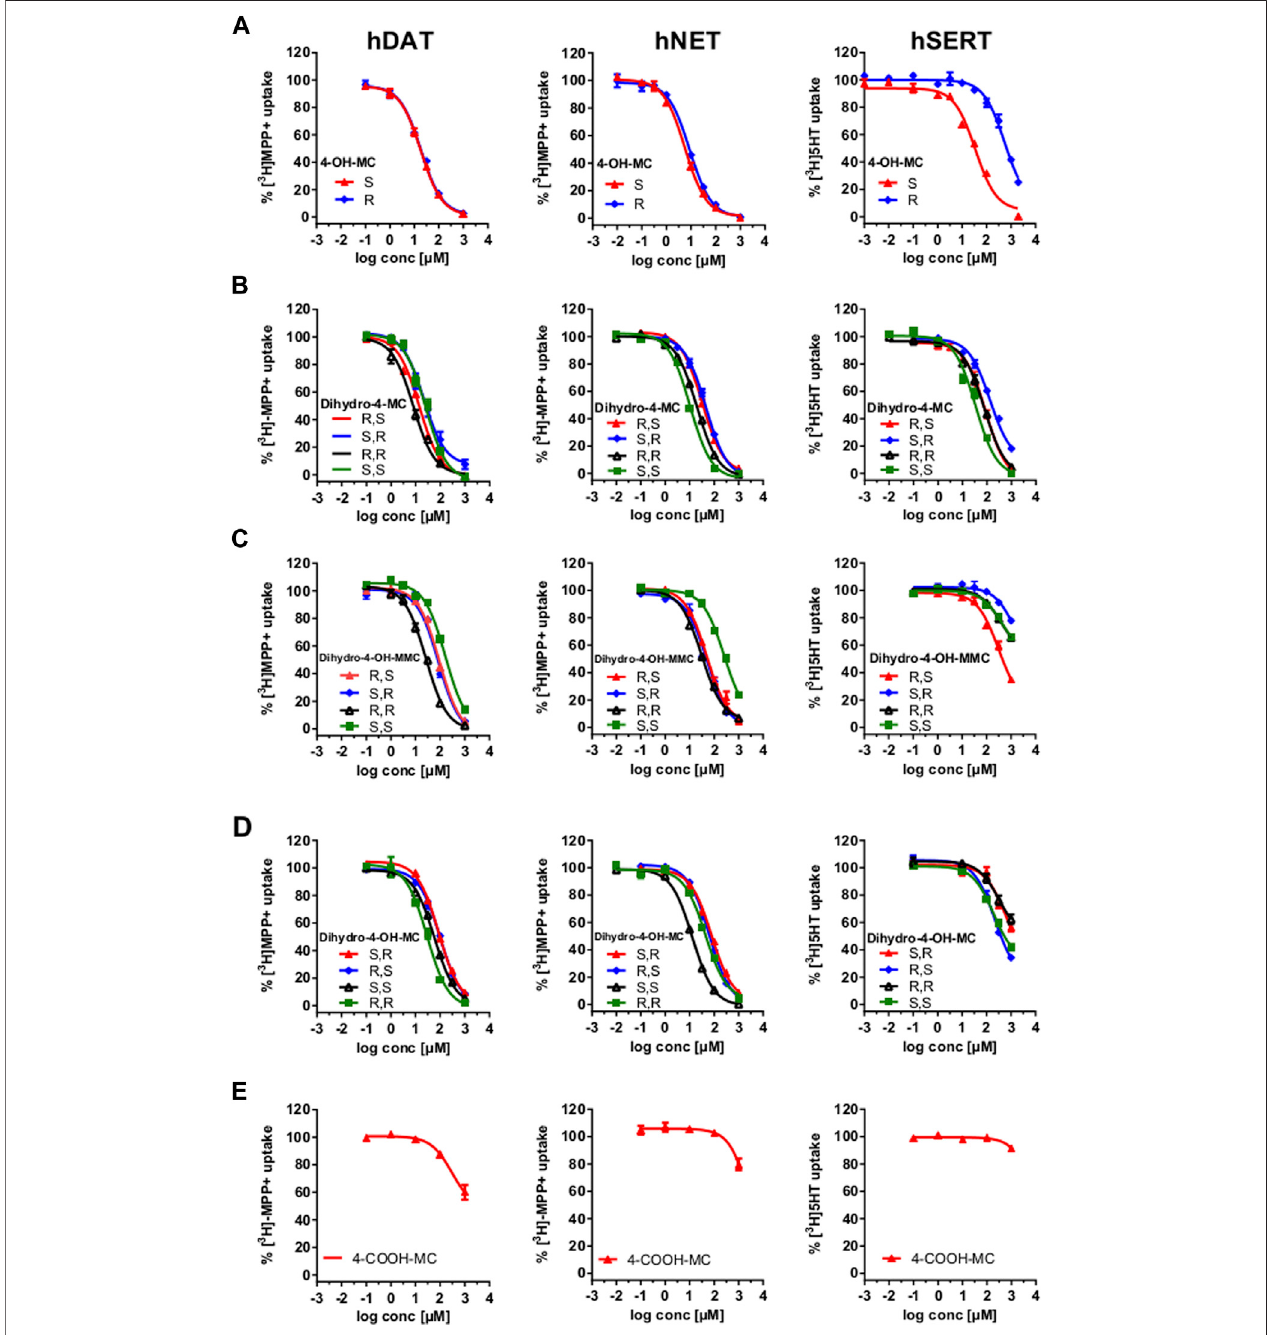
FIGURE 2 | Uptake-Inhibition of the synthesized enantiomers at hDAT (left) , hNET (middle) and hSERT (right) . Uptake of [ 3 H]MPP+ (DAT and NET expressing cells) and [ 3 H]5-HT (SERT expressing cells) was inhibited with increasing concentrations of the indicated test drugs. Data are shown as the mean ± SEM obtained from 3-5 individual experiments, performed in triplicate. (A) uptake-inhibition of 4-OH-MC enantiomers; (B) uptake-inhibition of dihydro-4 -MC enantiomers; (C) uptake-inhibition of Dihydro-4-OH-MMC enantiomers; (D) uptake-inhibition of Dihydro-4-OH-MC enantiomers; uptake-inhibition of the racemic 4-COOH-MC.